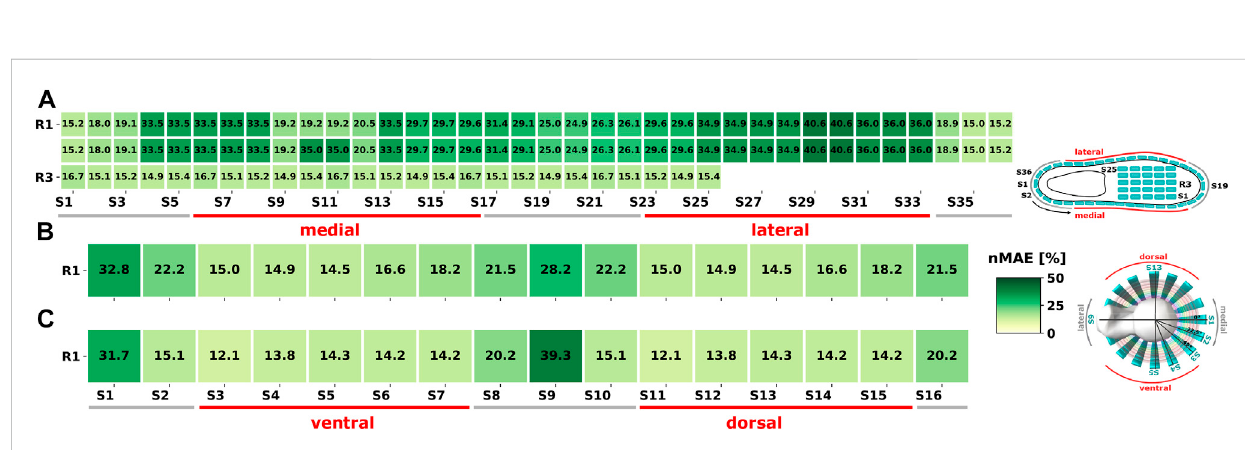
FIGURE 6 1-phase model: Exemplary nMAE heatmaps POST intervention on the less-affected body side for Algo. A2a. (A) All simulated shoe sensor positions. (B) Selected sensor ring at the upper leg. (C) Selected sensor ring at the lower leg. R: Ring; S: